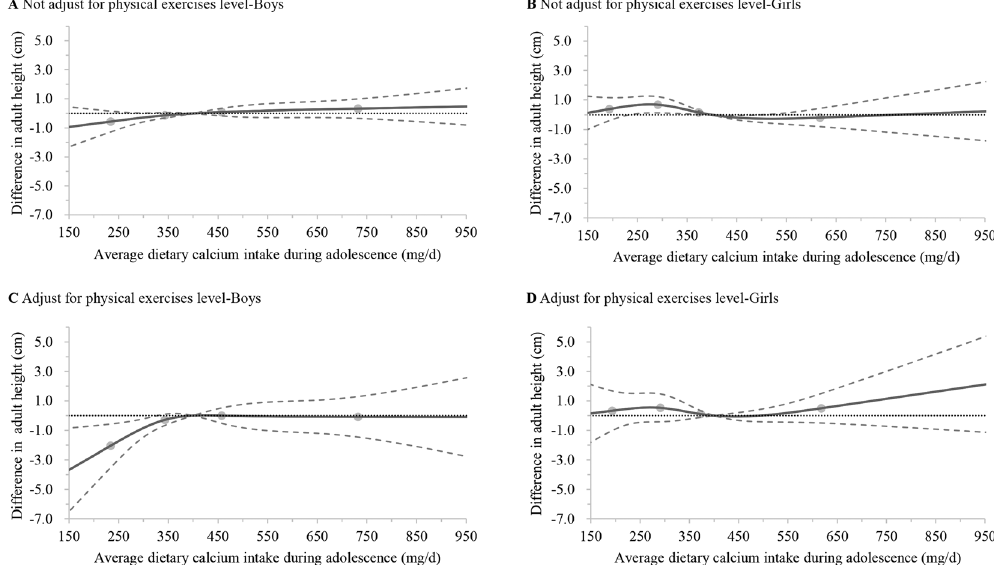
Figure 3. Multivariable adjusted dose-response associations between average dietary calcium intake during adolescence and adult height in boys and girls with plant-based diet. Multivariable adjusted dose-response curves were indicated by solid line and 95% confidence interval by dashed lines. Calcium intake was coded using an RCS function with four knots, represented by dots, located at the 5th, 35th, 65th, and 95th percentiles of the distribution of average intake of dietary calcium. Y-axis represents the difference in adult height between individuals with any value of calcium intake with individuals with 400 mg/d of calcium intake. Model A and B, using full data from 1989 to 2011, were adjusted for baseline age, height, and weight, adult age and weight, year of birth, paternal and maternal height, urbanization index, latitude, DNR, average dietary intake of total energy, average energy adjusted dietary intakes of protein, vitamin A, iron, and zinc during adolescence, stratum, and household income level. Model C and D, only using data since 1997, and additionally adjusted for baseline physical exercises level. RCS: restricted cubic spline; DNR: annual average direct normal